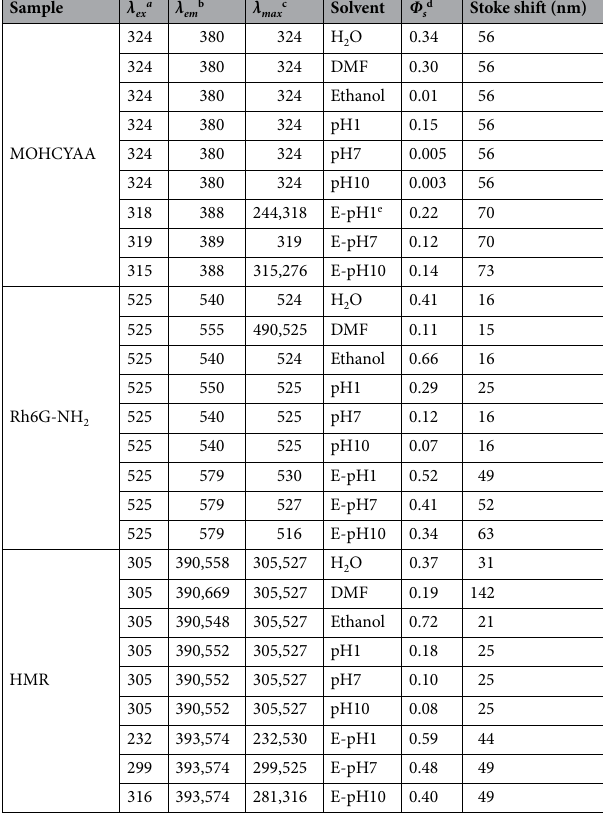
Table 1. Photophysical properties of pigments. a Excitation wavelength, b maximum emission wavelength, c maximum absorption wavelength, d fluorescence quantum yield, e pH in